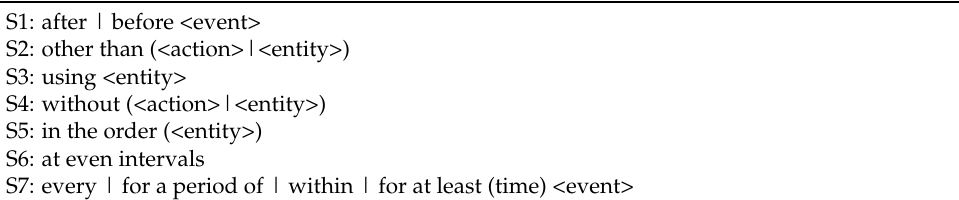
Table 5. Boilerplate Suffix Clauses (S j